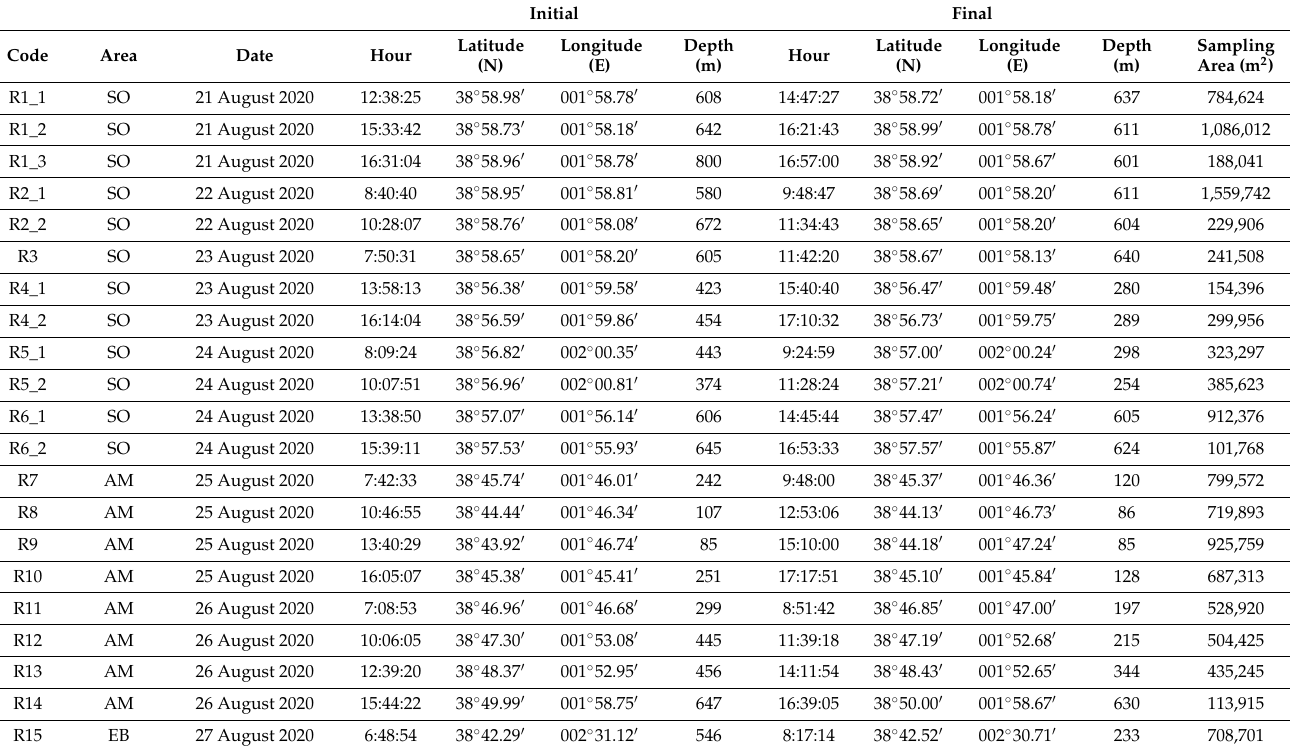
Table A6. Characteristics of the sampling stations carried out with the ROV Liropus 2000 in the Mallorca Channel seamounts Ses Olives (SO), Ausias March (AM), and Emile Baudot (EB) during the INTEMARES